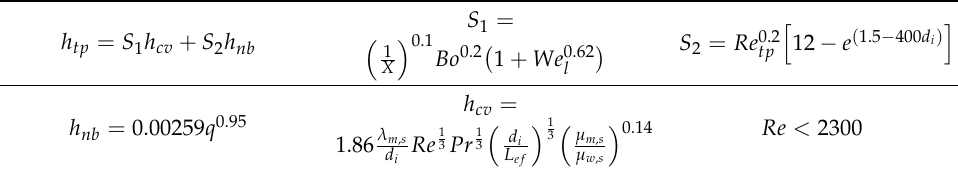
Table 9. Proposed correlation to predict the boiling heat transfer